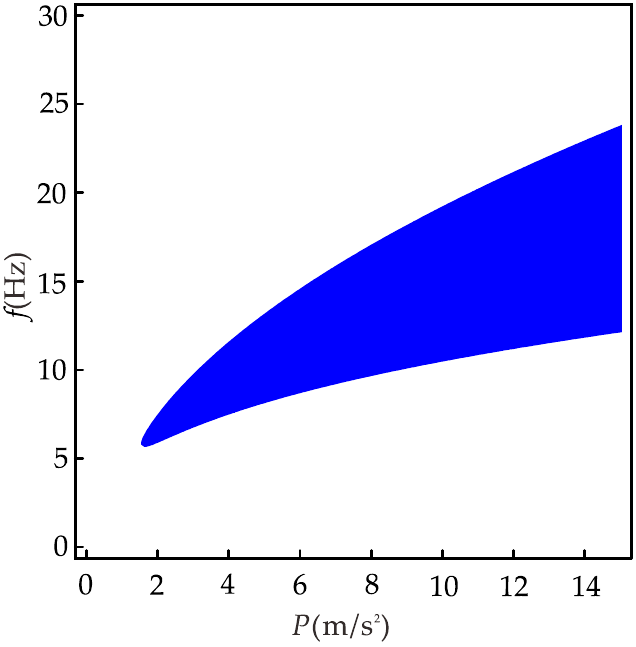
Figure 12. The region of 1/3 subharmonic resonance of the nonlinear system. Figure 13 is the diagram of the relationship between the response displacement amplitude and the excitation amplitude of the system (if not specified, it refers to the case of the primary resonance). When the excitation amplitude is less than 5.9 m/s 2 , the system has only a small vibration; when the excitation amplitude is 5.9~36.7 m/s 2 , the system has a single excitation amplitude corresponding to multiple response amplitudes, one unstable solution, and two stable solutions; and when the excitation amplitude is greater than 36.7 m/s 2 , the system can maintain large vibration. The trajectories of response amplitudes during forward and reverse sweep are shown by arrows 3 (cid:13) and 4 (cid:13) , respectively. When sweeping, the steady-state response under the previous excitation amplitude is the initial condition for the vibration at the next excitation amplitude. It can be easily seen that the steady-state motion of the system depends on the initial condition in the multi-value excitation amplitude region. This is similar to Figure 8a, where there is a jump during sweeping. For the range of excitation amplitudes that can produce multi-values, we cannot guarantee that the system always vibrates with large amplitudes. If the system performs small amplitude vibration, the efficiency of the energy harvester is greatly reduced. We are interested in considering the effect of 1/3 subharmonic